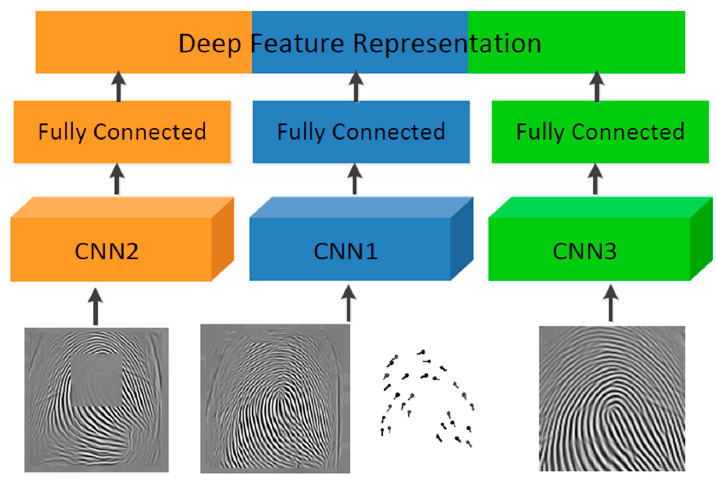
Figure 12. Deep-feature representation generation process using three multi-Siamese networks [83]. A data augmentation process was used in 5780 contactless and contact-based images from 320 fingers [78]; 3840 images were used in the training set while the rest were used for testing purposes. The image size remained 192 × 192 in every image. A public dataset was used to determine the performance and to compare and validate the dataset. The da- taset contains 1500 fingers data with 3000 contactless fingerprint samples. For the perfor- mance metrics and evaluation, the ROC method (receiver operating characteristics) and EER (equal error rate) were used. To obtain the fingerprint recognition, CMC (cumulative match characteristics) and rank-one accuracy methods were applied. The comparative ex- perimental evaluations are shown in Table 4. Also, in Table 5 shows the total summary of the described articles of deep learning in Section 5. Table 4. Experimental evaluation of two datasets.